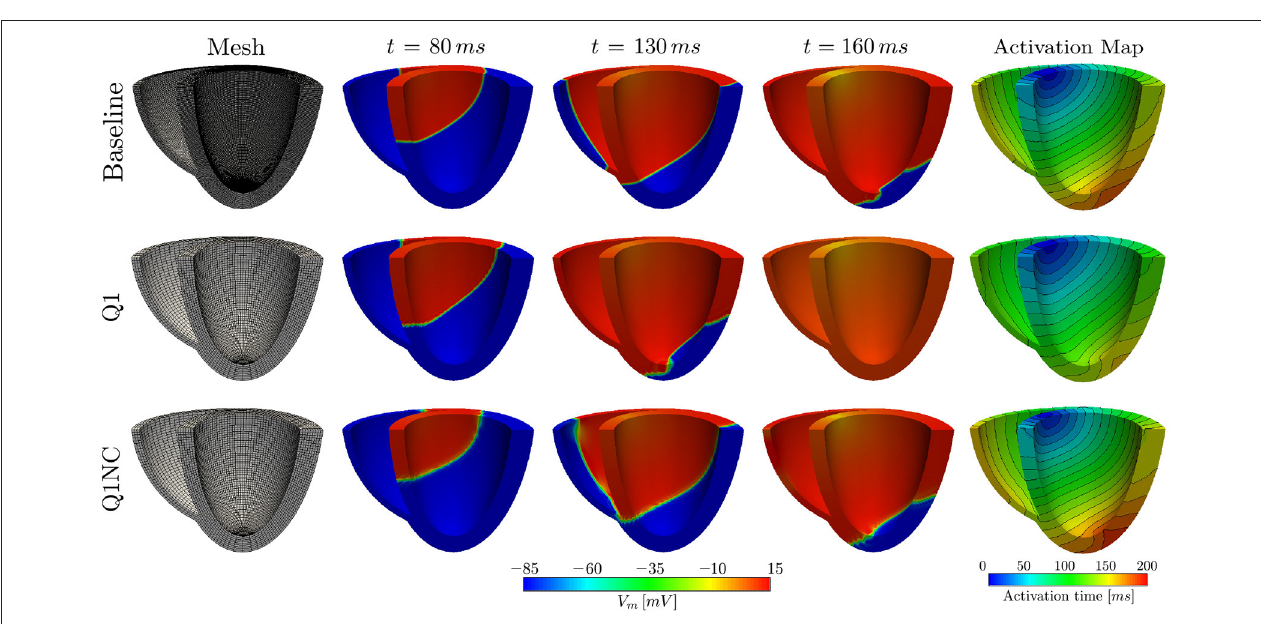
FIGURE 4 | Numerical simulations on human biventricular idealized geometries. The Q1NC model displays a propagating wave similar to the baseline case during the ventricular activation sequence, whereas the Q1 model hastens the electrical stimulation ahead of the baseline